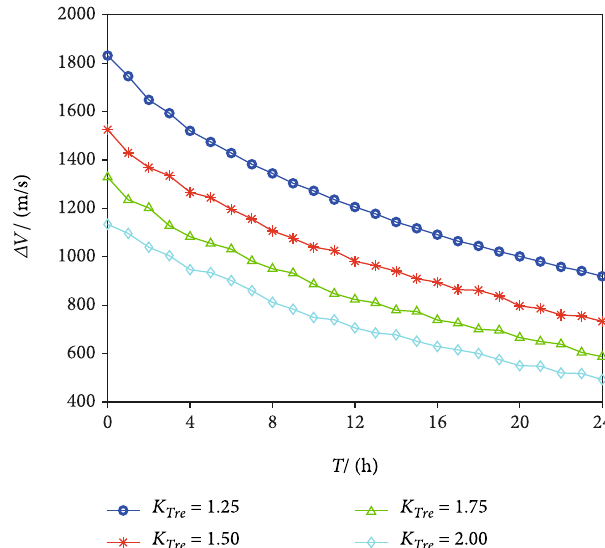
Figure 8: Total abort impulse versus the abort time of the two- impulse abort orbit under di ff erent maximum abort return time constraints.